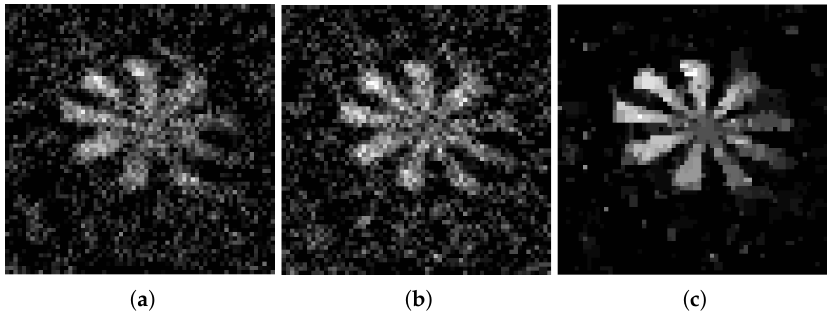
Figure 7. In the case of the sampling rate is 0.4, the image measured by Gaussian random matrix reconstructed by OMP ( a ), IHT ( b ), and TVAL3 ( c ) algorithms. The resolution of the image is all 64 × 64.